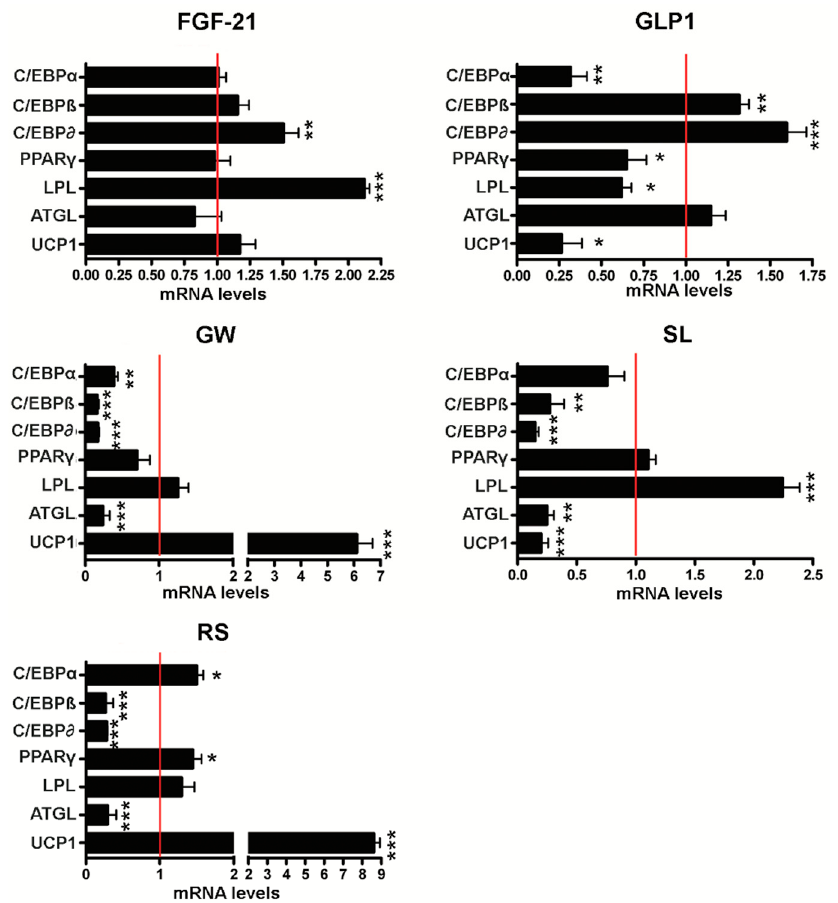
Figure 4. Gene expression analysis of adipose differentiation markers. RT-qPCR analysis of C/EBP α , C/EBP β , C/EBP δ , PPAR γ , LPL , ATGL , and UCP1 in MSCs treated with browning agents during white